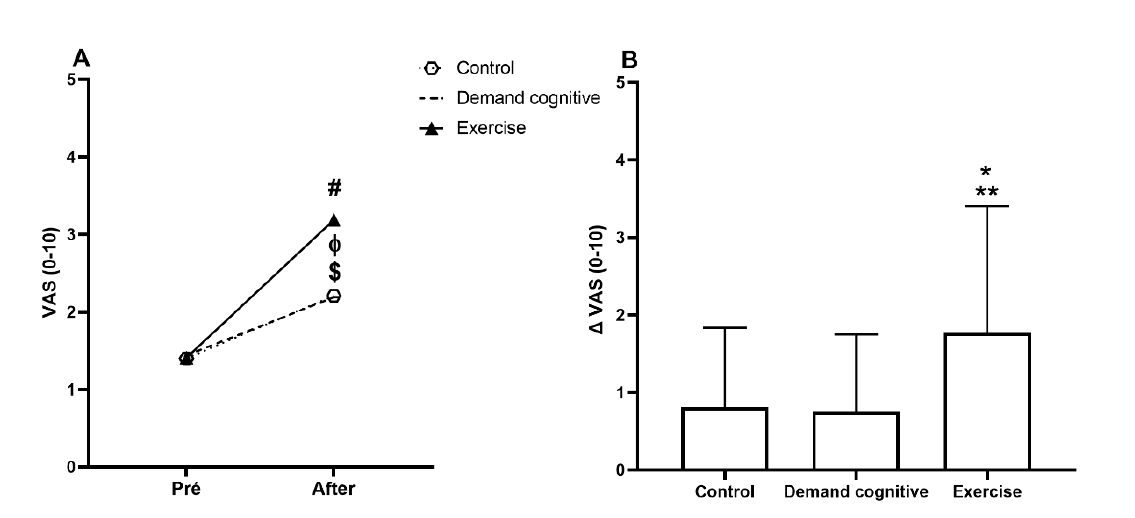
Figure 2 - (A) Behavior of mental fatigue (pre and post-control sessions, cognitive demand, and exercise). Note: (Φ) and ($) p <0.05 difference from the pre and post moments in the control and cognitive demand sessions, respectively. (#) p <0.05 compared to the pre-exercise and post-session cognitive demand. VAS =